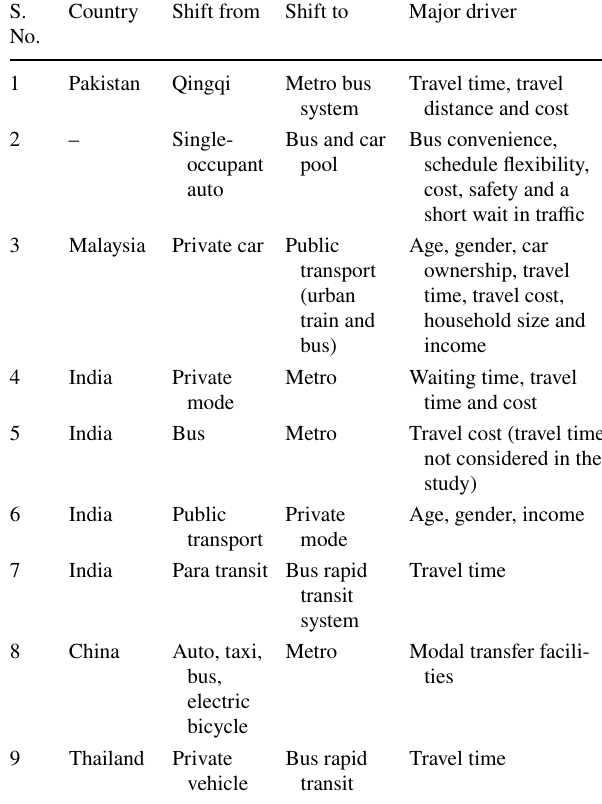
Table 1 A comparison among the selected studies S.